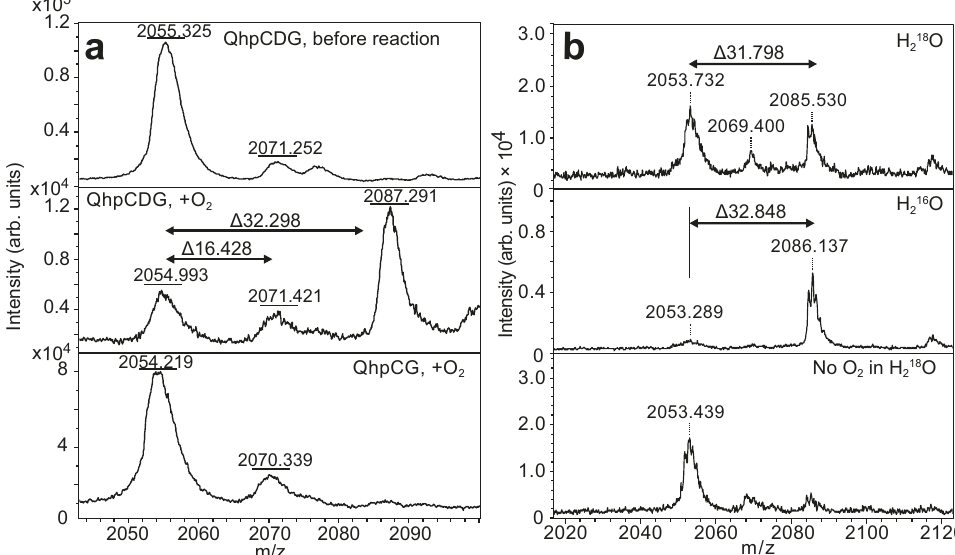
Fig. 3 Product analysis of QhpG reaction. a MALDI-TOF mass spectrometric analysis of the QhpG reaction products in the QhpCDG ternary complex before (top panel) and after (middle) addition of O 2 -saturated buffer and with the free crosslinked QhpC (bottom) (fragment d of Asp-N digestion). b MALDI-TOF mass spectrometric product analysis for the QhpG reactions conducted in H 2 18 O-buffer (top panel), H 2 16 O-buffer (middle), and without O 2 addition in H 2 18 O buffer